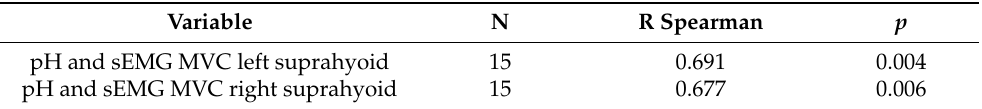
Table 3. The relationship between pH and maximum voluntary contraction (MVC) of left and right suprahyoid